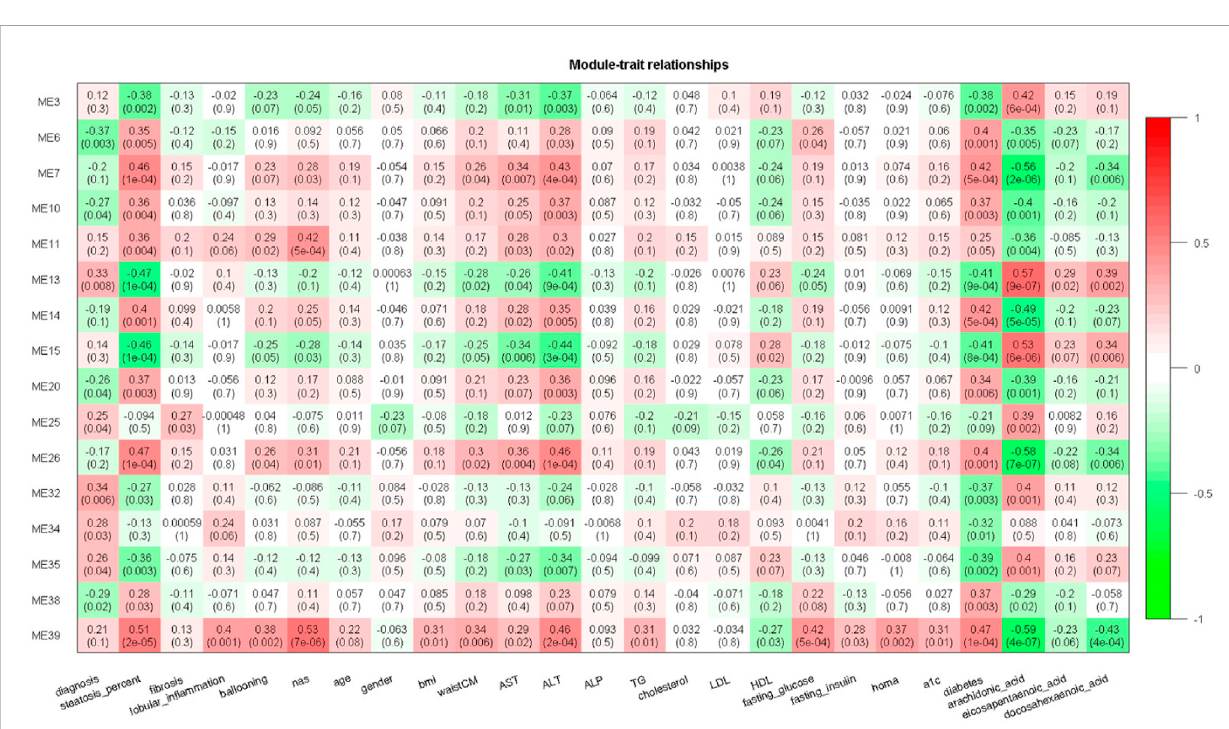
and 1E-7 respectively. Further analysis shows that the two components are upregulated during NAFLD progression. Patients with NASH and advanced fi brosis had greater fractions of fi broblasts